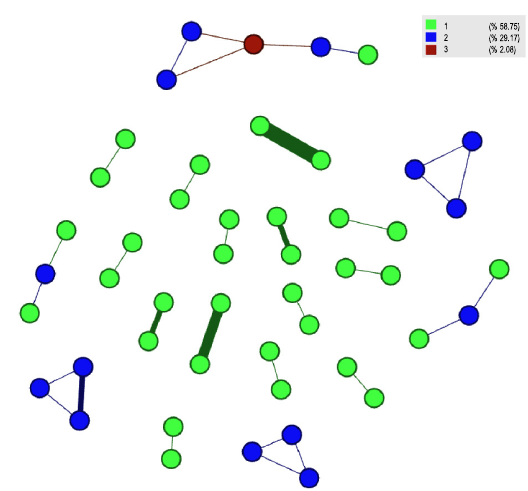
Fig. 8. Europe market